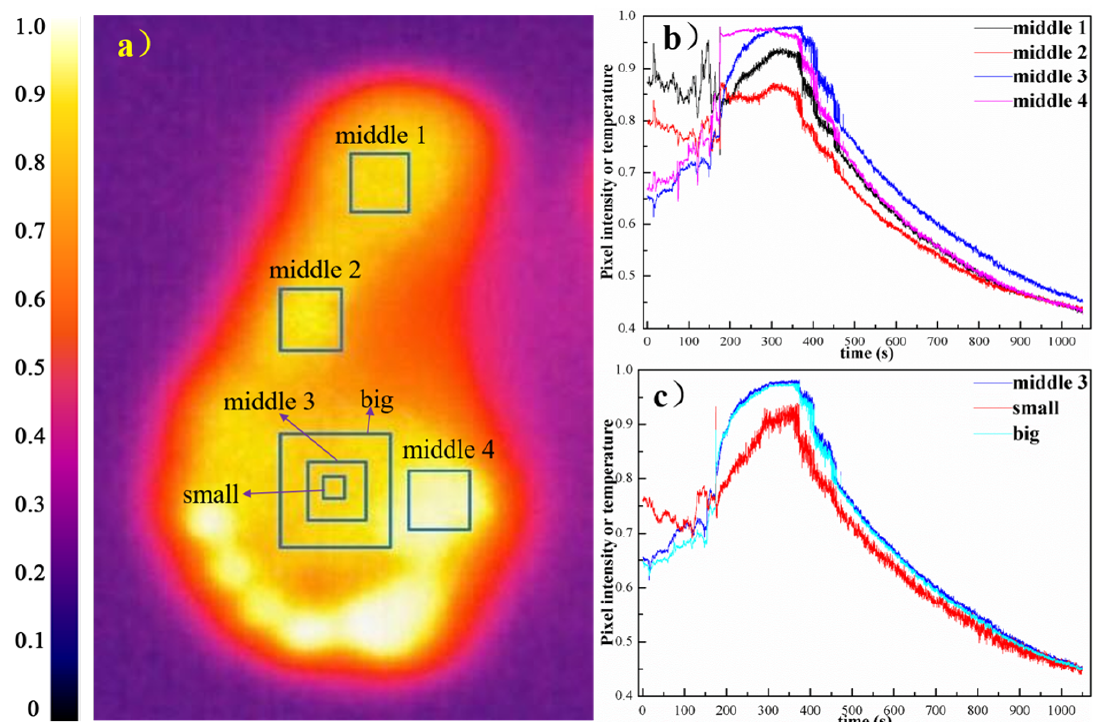
Figure 9. Influence of ROI selection on generation of thermal curve: ( a ) possible ROI selection in the sole of foot; ( b ) thermal curves extracted from different ROIs; and ( c ) thermal curves extracted from the same ROI with various sizes. (The pixel values are